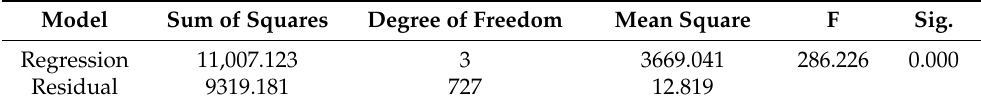
Table 6. ANOVA test results for the significance of the model.